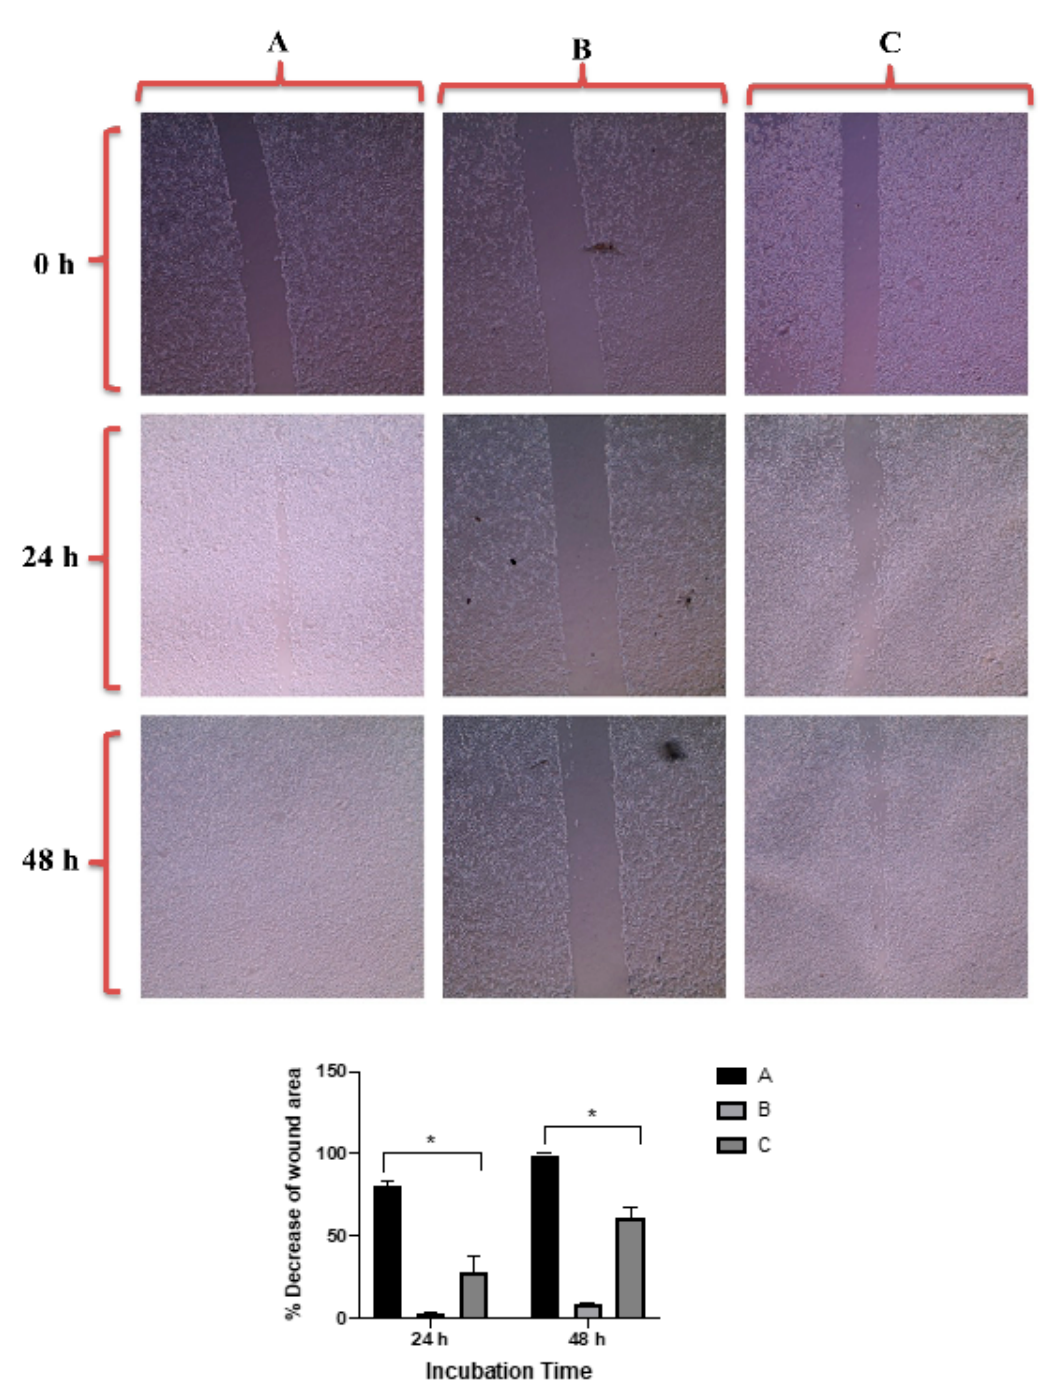
Figure 10. Up: In vitro cell migration of DU-145 cell line (control untreated cells) ( A ), upon treatment with positive control (quercetin) ( B ), and upon treatment with GNRs-PEG-PDA ( C ). Magnification power: 10 × . Down: The percentage decrease in wound area was estimated using ImageJ. Data are represented as mean ± standard deviation (SD), n = 3. t -test was employed for the difference assessment; * p <